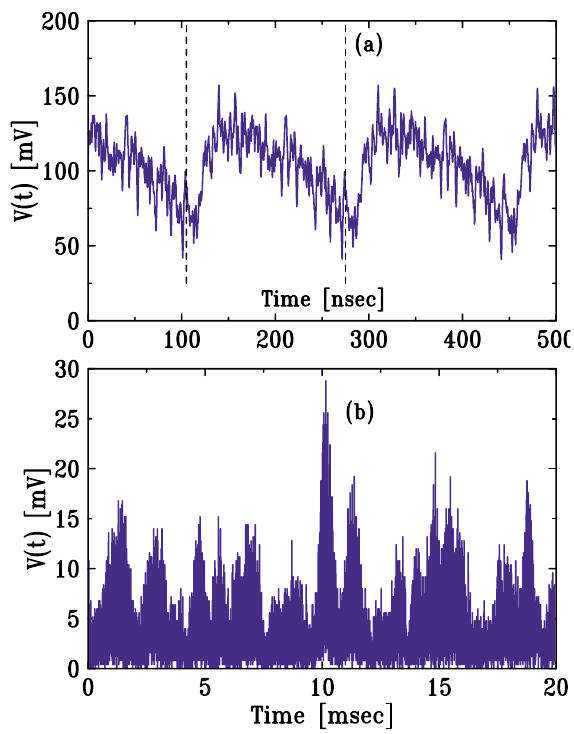
FIG. 8. (Color) The time structure of the amplified A peak . (a) Fast time interval for I (cid:6) 85 mA and signal for I < I t (b) slow time interval for I (cid:6) 26 mA